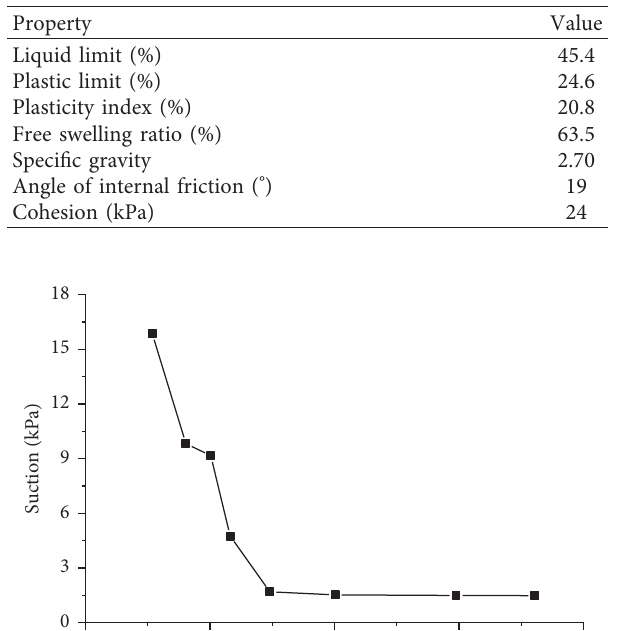
Table 1: Properties of the soil. Table 2: Mineral composition of the